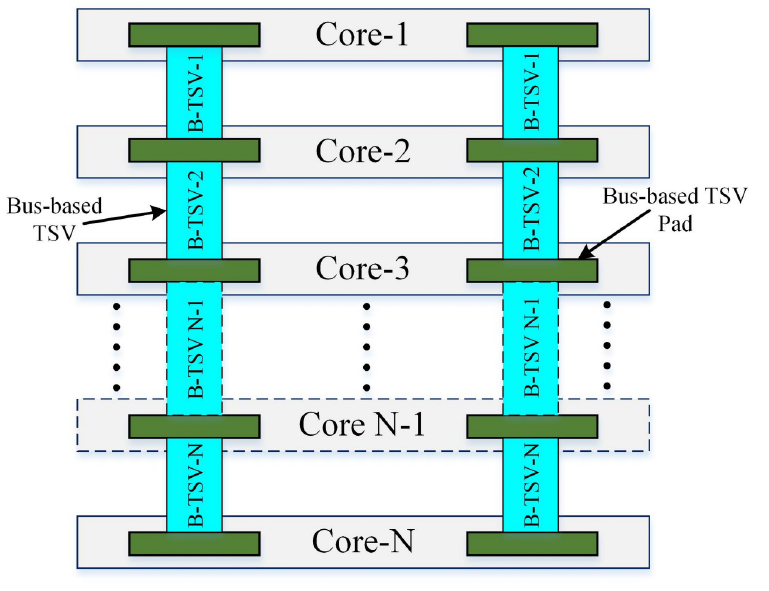
Fig 6. Bus-based